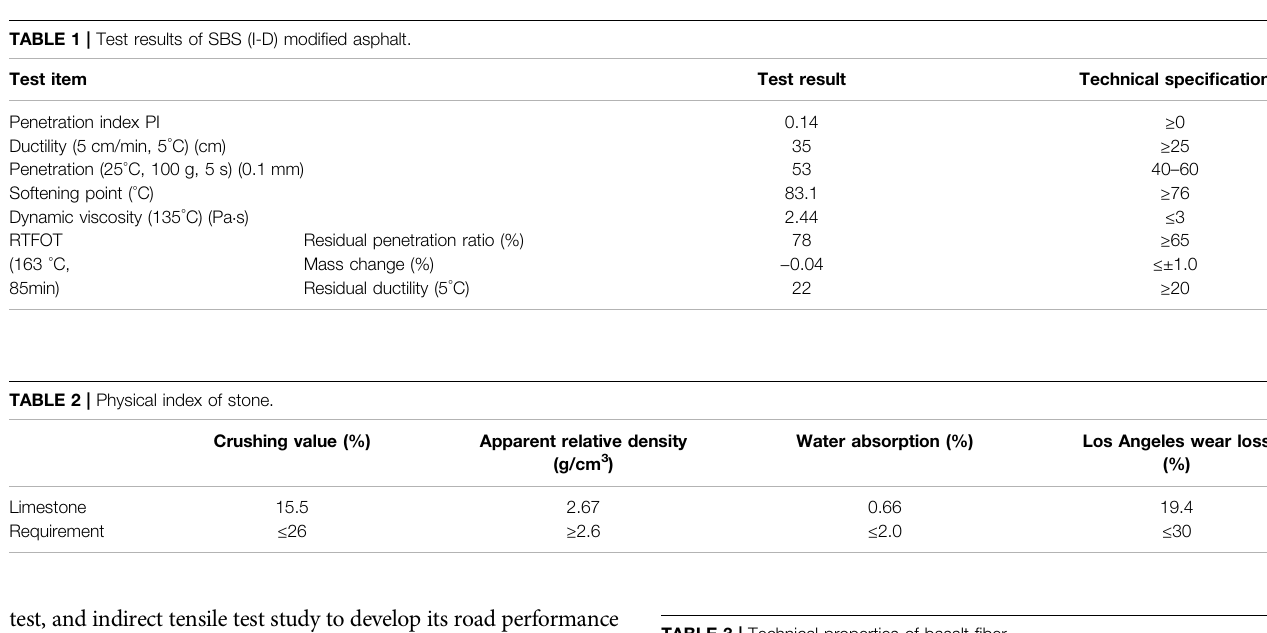
TABLE 3 | Technical properties of basalt fi